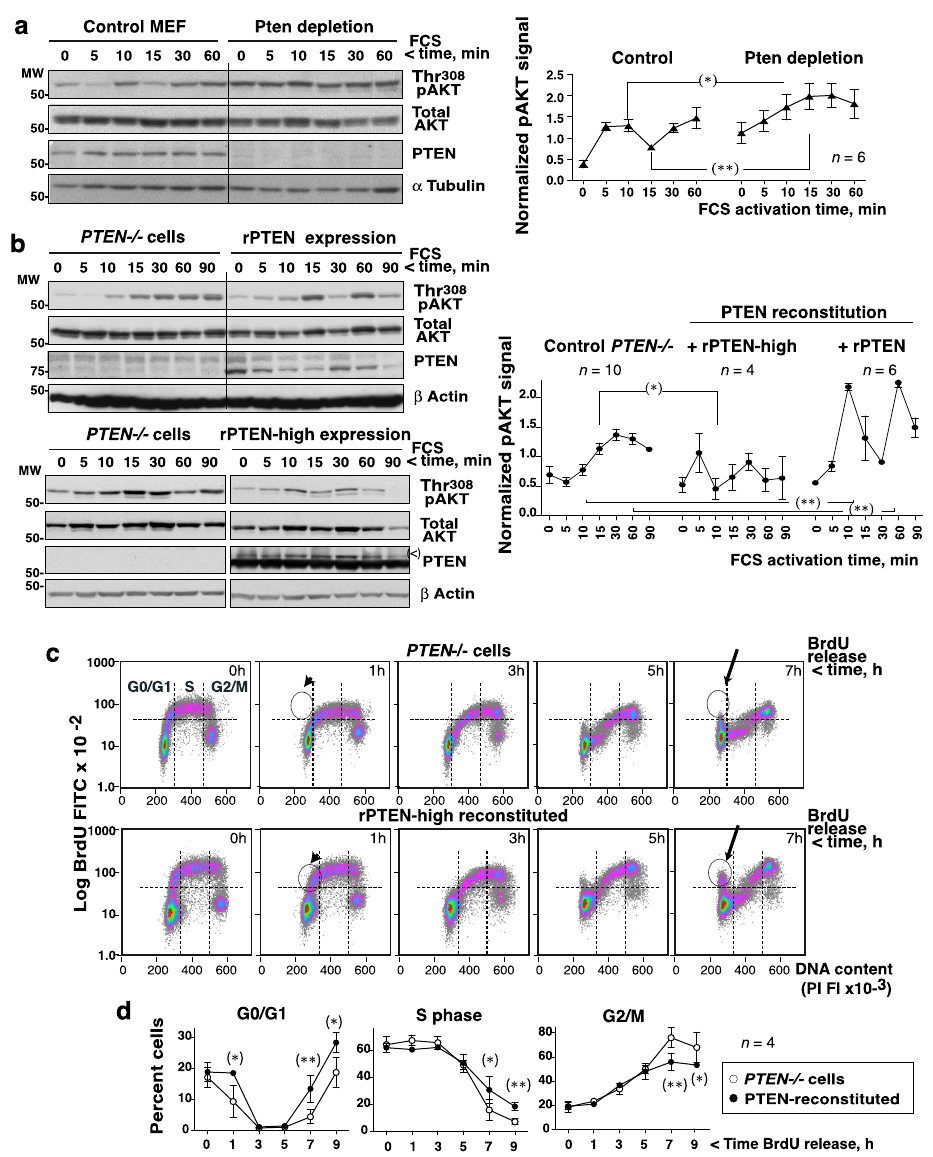
Figure 3. pAKT fluctuations require PTEN expression and affect cell cycle progression. ( a ) MEF transfected with a control or a Pten siRNA (72 h) were grown to confluence, incubated without FCS (2 h), then treated with FCS (15%) for different times. Blots show the PTEN and Thr308pAKT levels at different time points. The graphs represent the relative pAKT signal (corrected for AKT and α − tubulin) normalized to the mean pAKT signal for control MEF (considered as 1) (mean ± SD, n = 6). ( b ) PC3 cells were transfected with control, PTEN-Luc, or pRK5-PTEN (high expression, indicated) cDNAs (48 h) and then activated with FCS as in ( a ). Blots and graph plotting were as in ( a ). The upper band in the PTEN blot (indicated (<)) comes from the previous Akt blot. ( c , d ) Control or pRK5-PTEN-reconstituted PC3 cells (as in b) were labeled with BrdU (20 µ M, 1 h), then deprived of BrdU, and incubated for different times. ( c ) DNA content of the BrdU+ cells as determined by flow cytometry. Arrowheads point at BrdU+ cells in the G1-S phase; arrows point to the BrdU+ cells arriving at G0/G1 after G2/M ( c ). ( d ) The graphs show the proportion of cells in each phase at different times (mean ± SD, n = 4). * p < 0.05, ** p < 0.01 Student’s unpaired t